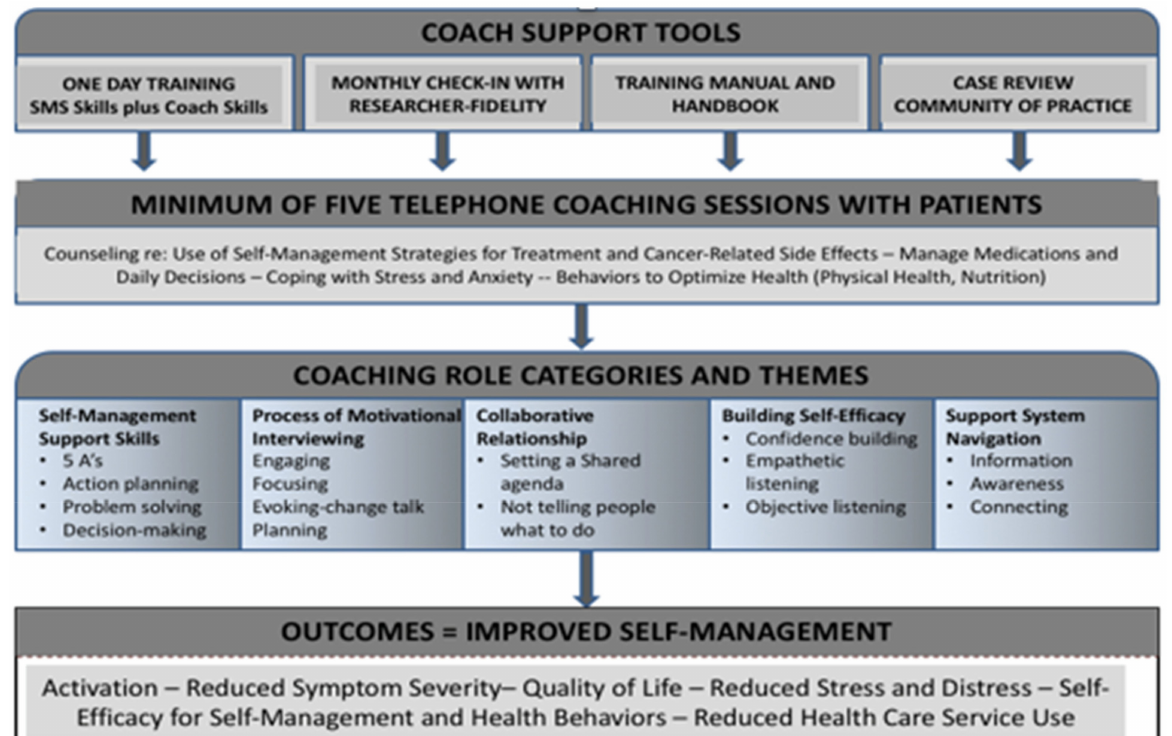
Figure 4. SMARTCare cancer SMS coaching intervention